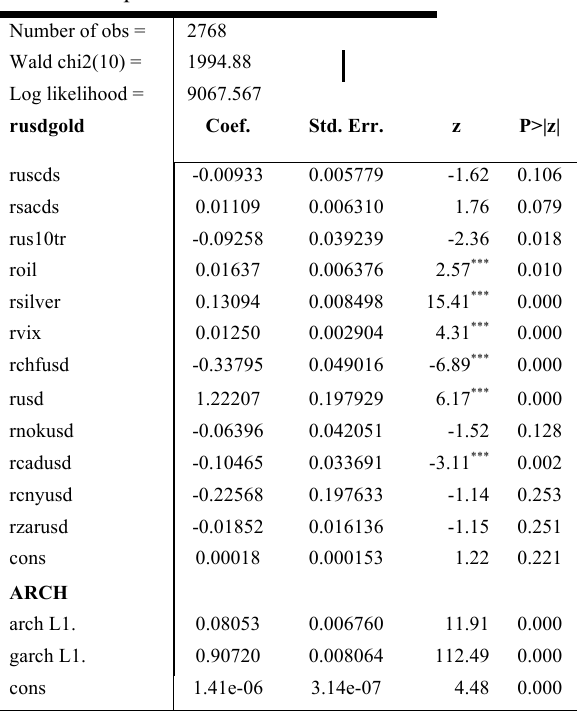
Table 2 GARCH model estimation results for